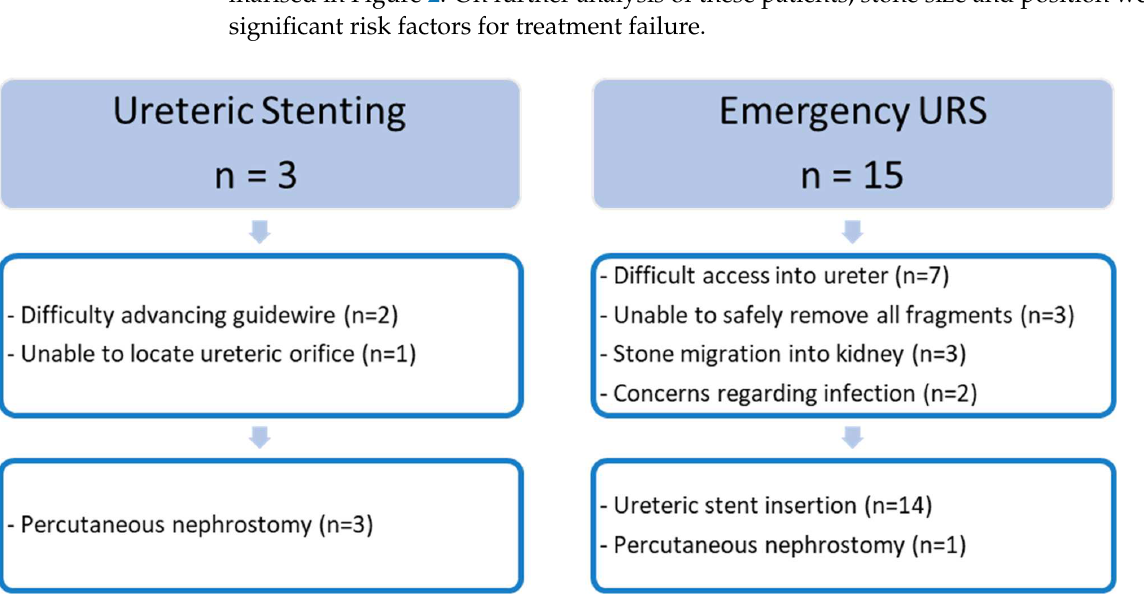
Figure 2. Reasons for treatment failure and subsequent treatment.